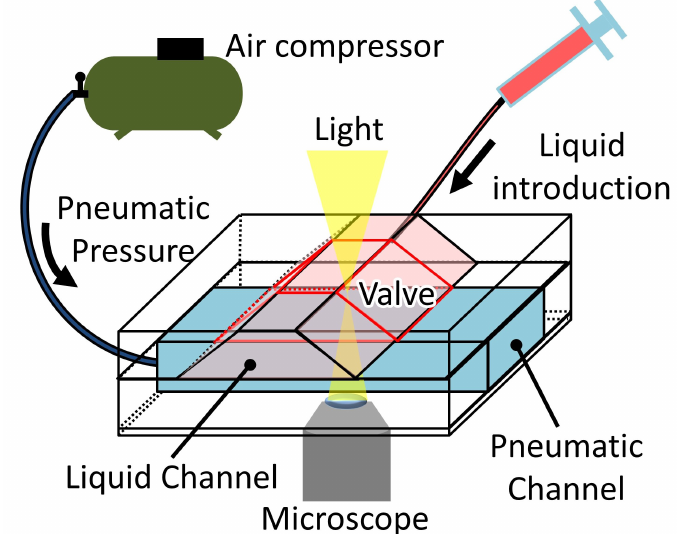
Figure 8. Experimental setup for the performance measurement of the microvalve. Occasionally, the frames had afterimages of fast-flowing beads. Such fast bead flows were not analyzed because the afterimages may have reflected inaccurate speeds; however, the relatively slow bead flows with clear images were analyzed. The flow velocities of the microbeads were measured by tracking the positions of three beads selected in each frame of the video over six frames. The average flow velocity was obtained from the velocities of the three